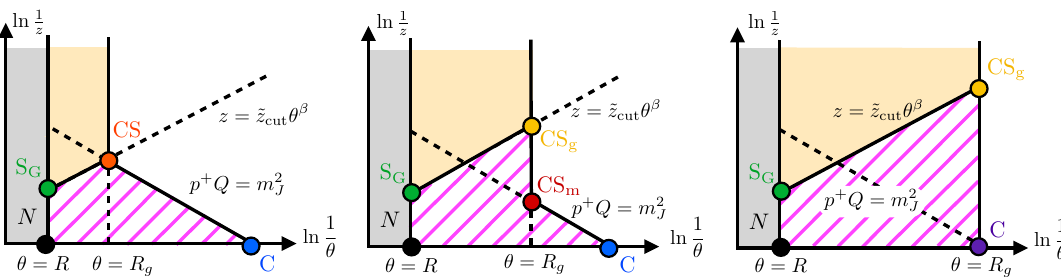
Figure 2 . The mode picture for three regimes of large (left), intermediate (center) and small (right) groomed jet radius, labeling emissions with their energy fraction z and angle θ relative to the emitting particle. The area shaded in yellow corresponds to soft dropped radiation, while the area hatched in magenta is vetoed by the measurement (black lines), where dashed segments do not enforce vetoes. Emissions in the area shaded in grey lie out of the initial (ungroomed)